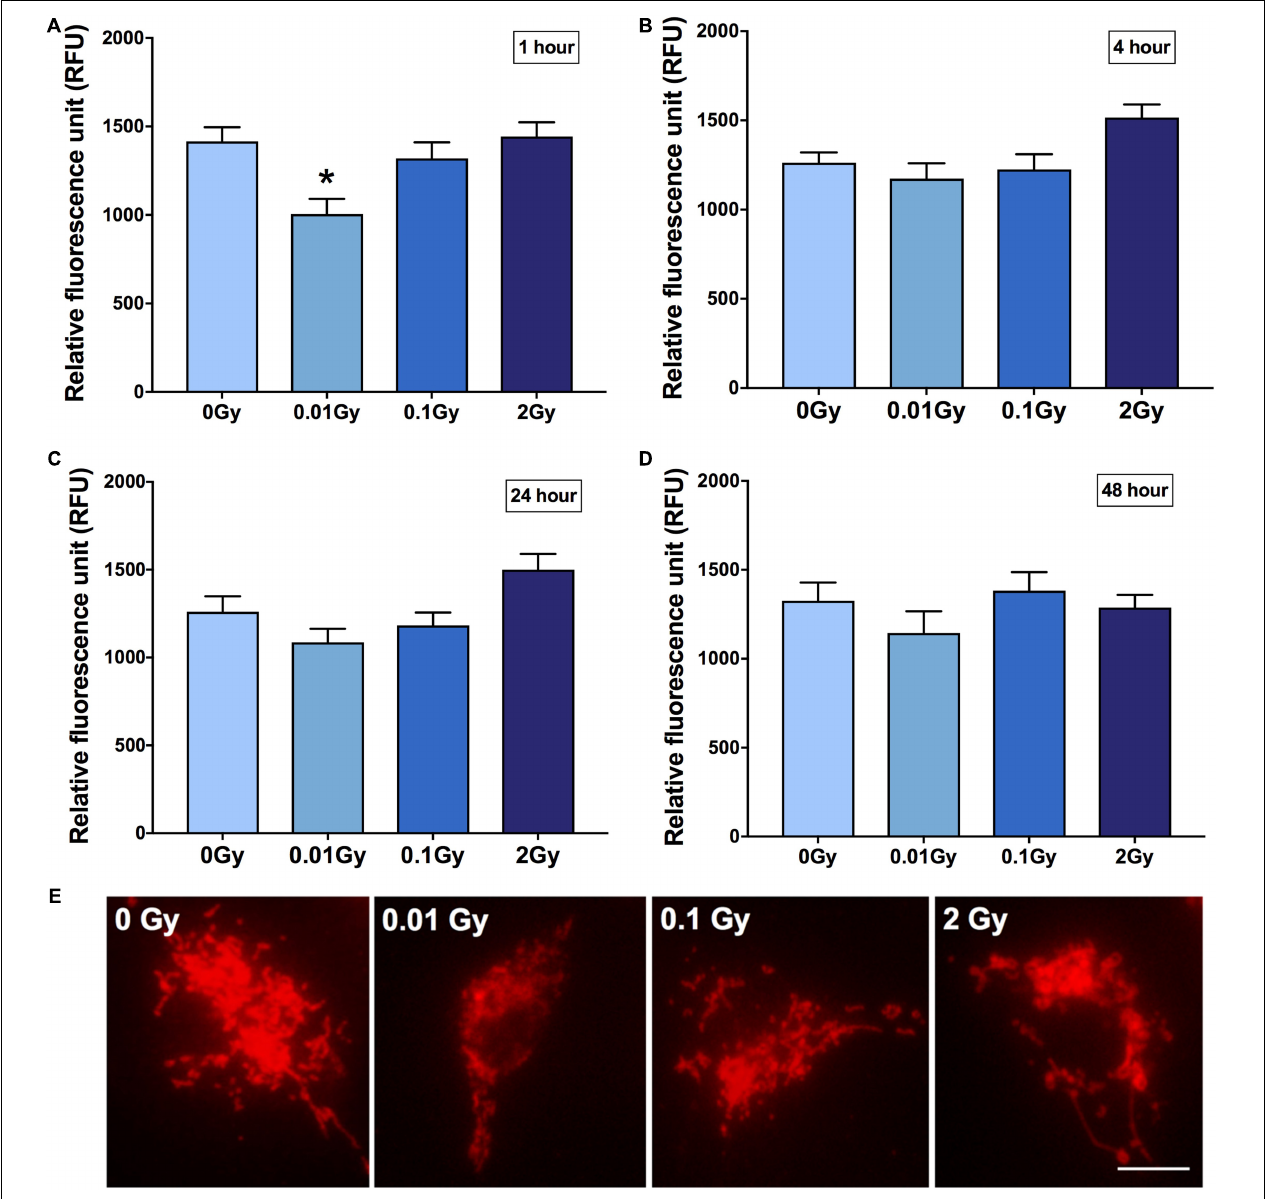
FIGURE 2 | TSPO expression in primary cultured microglia after gamma radiation exposure. Primary microglial cell cultures were exposed to 0.01, 0.1, or 2 Gy plus a sham-irradiated control (0 Gy). TSPO immunoreactivity was quantified in cells as a function of fluorescence intensity at (A) 1 h (B) 4 h (C) 24 h and (D) 48 h post-irradiation. A consistent reduction in TSPO expression was demonstrated across all time points after 0.01 Gy, relative to control, though was only statistically significant after 1 h (* p < 0.05). Contrastingly, an increase in TSPO expression was found in 2 Gy irradiated cells from 4 to 24 h, relative to control, though was not statistically significant ( p > 0.05). (E) Representative images of irradiated and control microglia immunostained for TSPO (1 h post-irradiation). Data are represented as mean and standard error, and is the average of 3 experiments. Scale bar = 10 µ m.